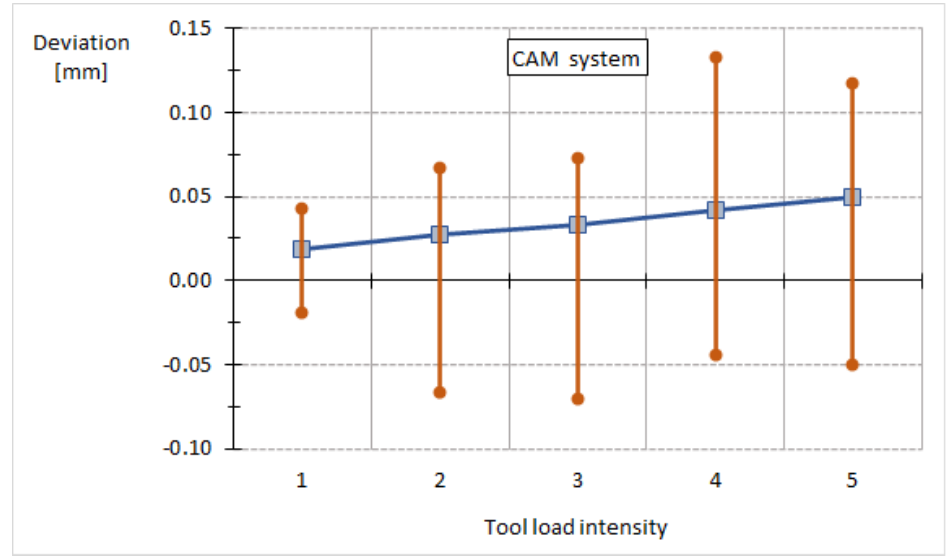
Figure 7. Deviations on the sidewalls of the pockets made with the CAM system.